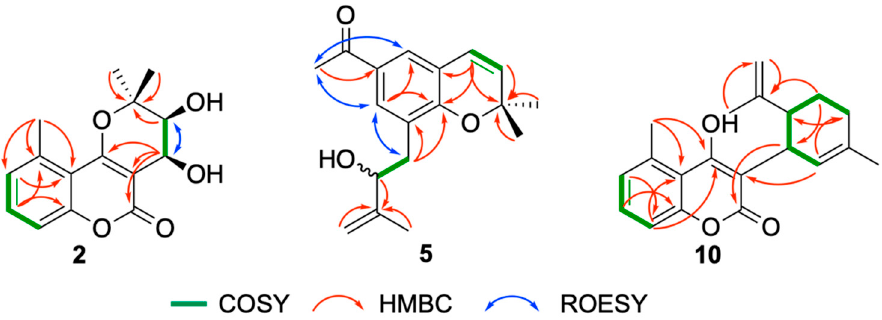
Figure 4. Selected COSY, ROESY and HMBC correlations of compounds 2 , 5 , and 10 . Table 1. 1 H NMR (600 MHz) Spectroscopic Data of 2 , 5 , 6 , and 10 a . Pos.